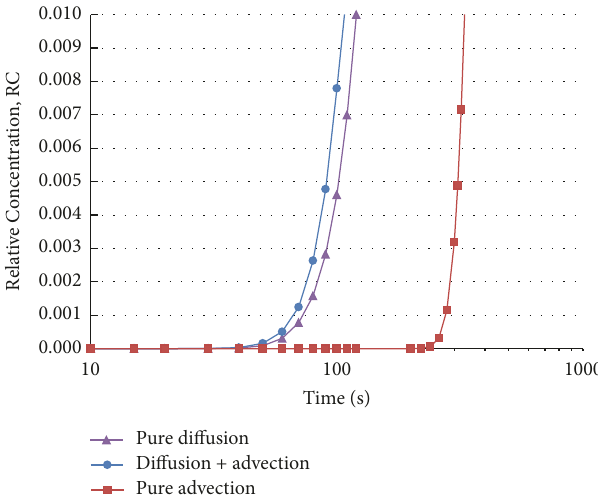
Figure 4: Relative Concentration (RC) over time at the outlet for pure diffusion, diffusion with advection, and pure advection (numerical solution for the case with length scale of 1